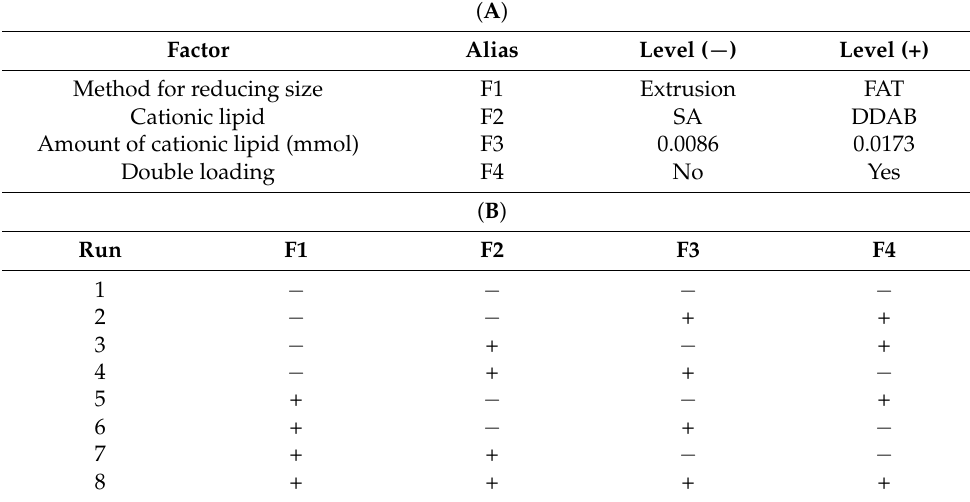
Table 1. (A) Factors selected in the study with the nomenclature and their levels. FAT: freeze–thawed vesicles; SA: stearylamine; DDAB: didodecyldimethylammonium bromide. (B) L8 Taguchi orthogonal array used in this study. ( − ) Lower level of the factor; (+) higher level of the factor. F1: method for reducing size; F2: cationic lipid; F3: amount of cationic lipid (mmol); F4: double loading. ( A ) Factor Alias Level ( − ) Level (+) Method for reducing size F1 Extrusion FAT Cationic lipid F2 SA DDAB Amount of cationic lipid (mmol) F3 0.0086 0.0173 Double loading F4 No Yes ( B ) Run F1 F2 F3 F4